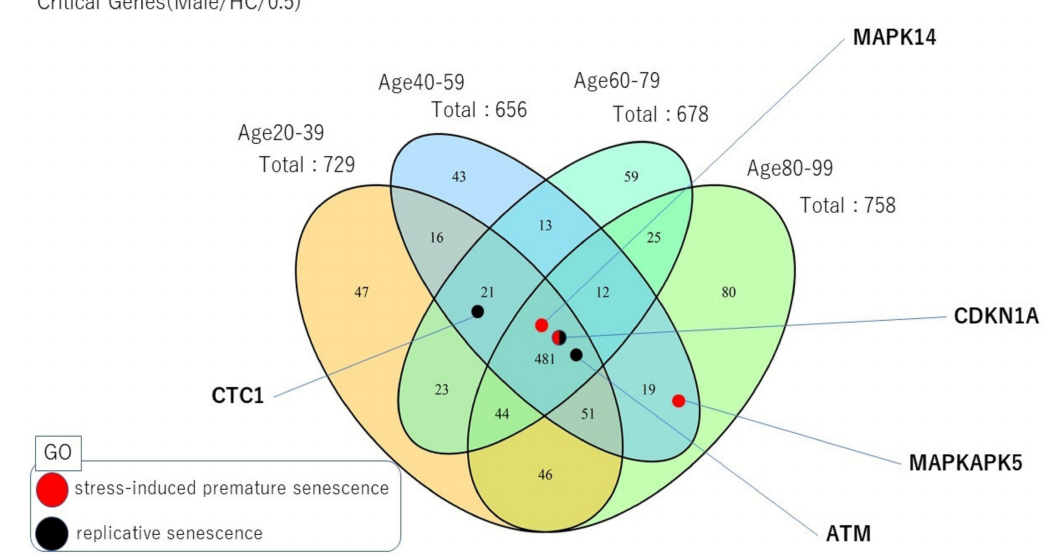
Figure 10. Venn diagram for male HC brain tissue at Θ = 0.5 showing the numbers of critical proteins for each age period and those shared across ages. The possible critical ageing protein candidates that were identified were related to stress-induced premature senescence and replicative